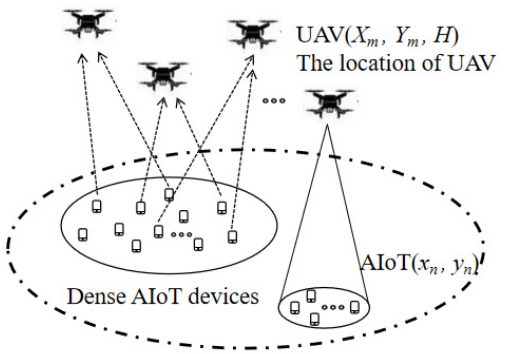
Figure 1. Illustration of the UAV deployment optimization in energy-efficient AIoT data collection. The connection relationship Conn n,m of the n th AIoT device and the m th UAV can be expressed